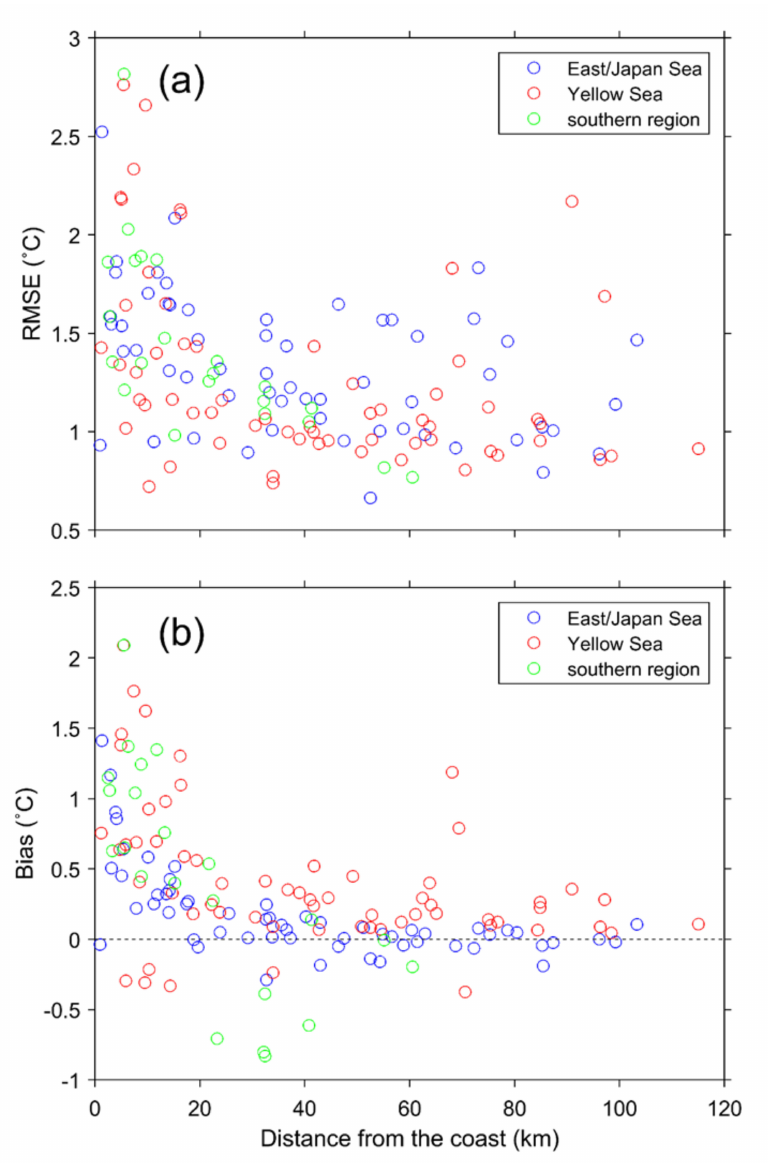
Figure 7. ( a ) RMSE and ( b ) bias error between satellite SST and in situ KODC temperatures with respect to the distance from the coast